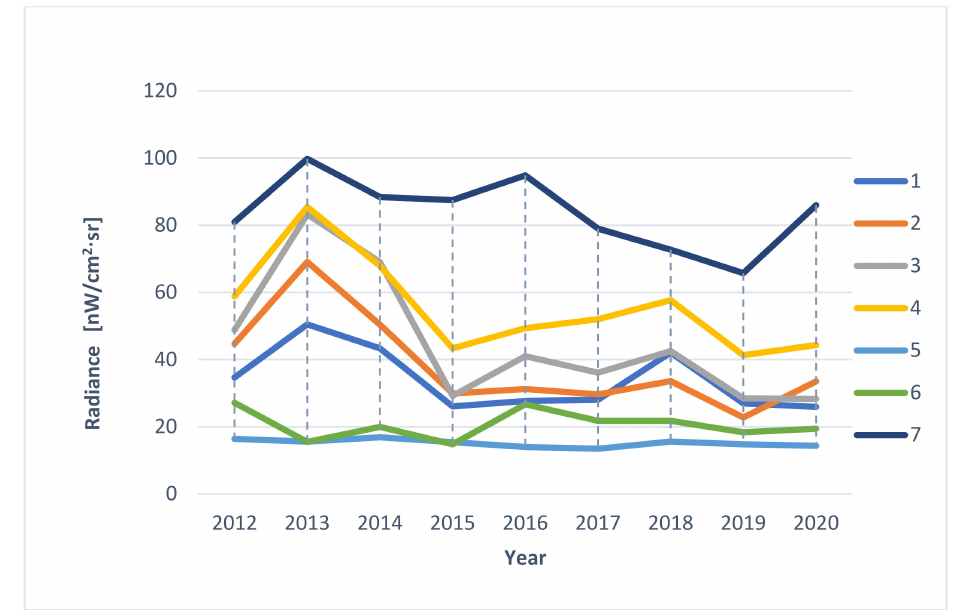
Figure 10. Radiance changes in 2012–2020 according to the service https://www.lightpollutionmap.info/ (accessed on 5 May 2021).